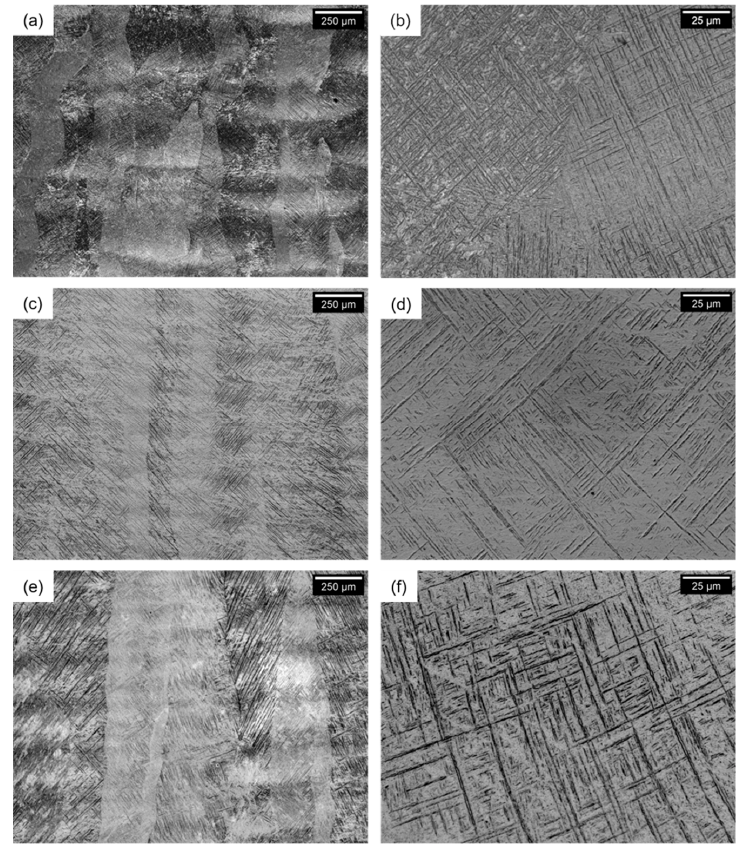
Figure 2. Optical micrographs of samples built in conditions: protective argon flow (ArS) ( a , b ), sealed environment using a non-preheated platform (SE-CB) ( c , d ) and sealed environment using a preheated platform (SE-HB) ( e , f ).